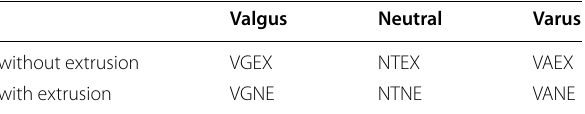
Table 1 The six models, varying in joint line convergence